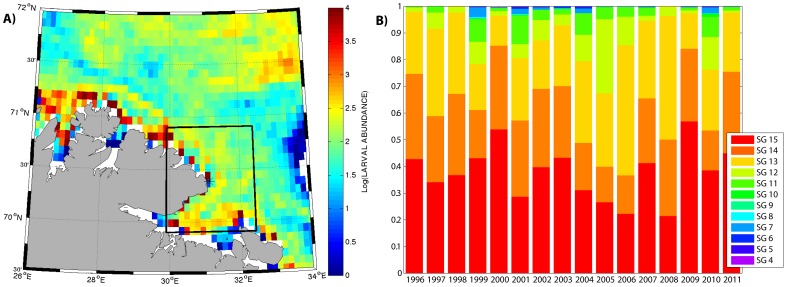
Original spawning grounds of cod larvae reaching Hornøya.
A) Accumulation of cod larvae around Hornøya during July 2005. B) The original spawning grounds (SG) of cod larvae entering the foraging area of common guillemots (black box) around Hornøya during the approximate chick-rearing period 9 June to 7 July.